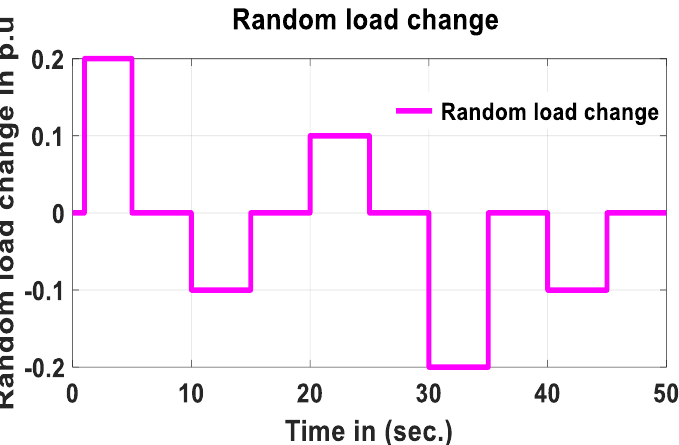
Figure 19. Random load change pattern in the range of [ − 0.2 to 0.2].